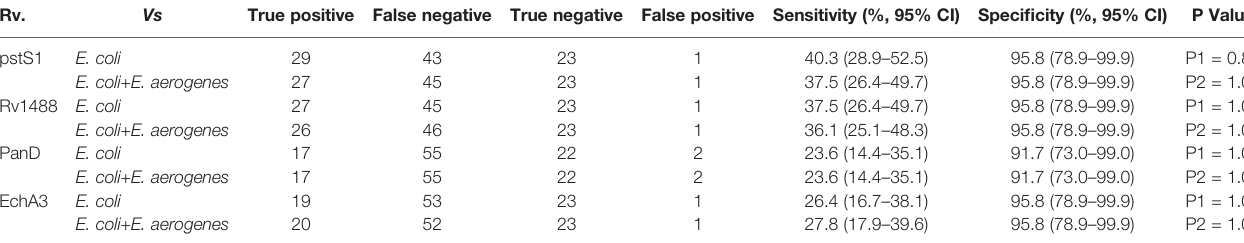
TABLE 3 | Comparison of the effect of pre-adsorption by E. coli and E. aerogenes & E. coli.